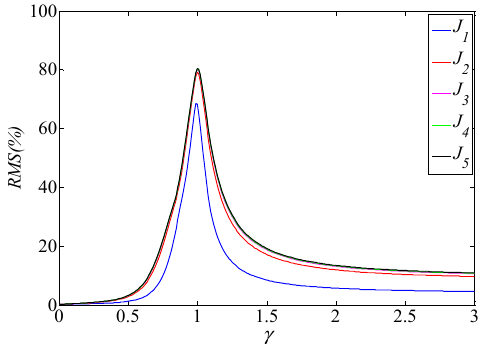
Figure 3. Control effectiveness of the TRID system with different frequency modulation ratios.